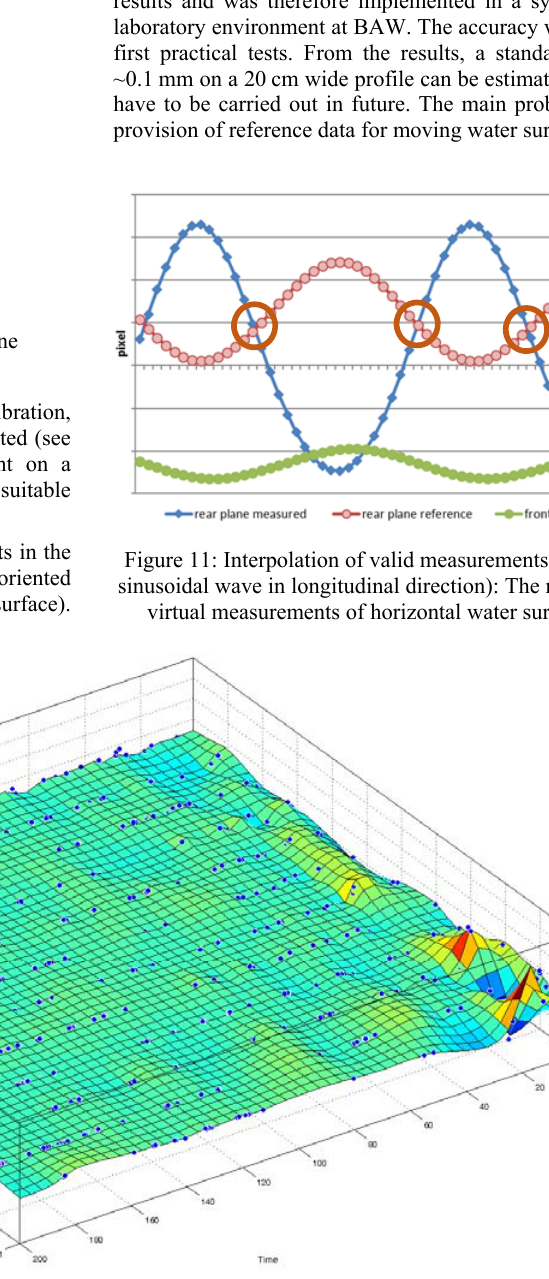
Figure 12: Measured water profile line over a time period of 4 seconds, acquired with 25 fps. The surface was interpolated between discrete profile points (blue